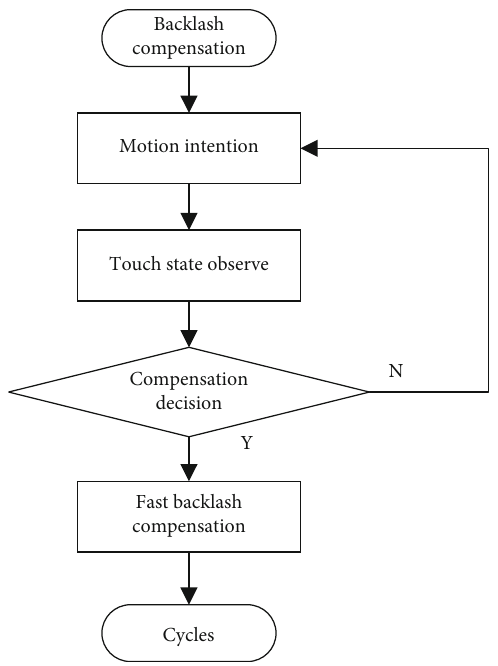
Figure 11: Process diagram of backlash